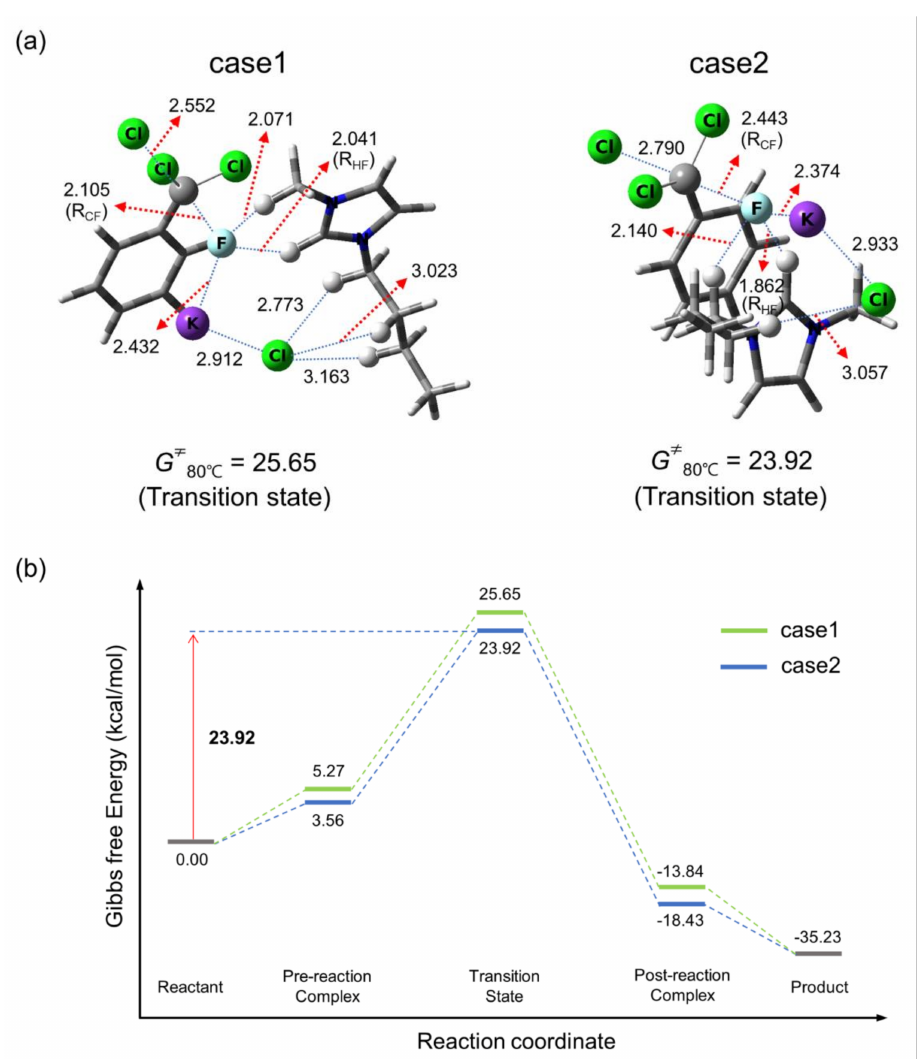
Figure 3. Calculated ( a ) transition states and ( b ) energetics of S N 2 fluorination in [bmim]Cl with substrate: KF =